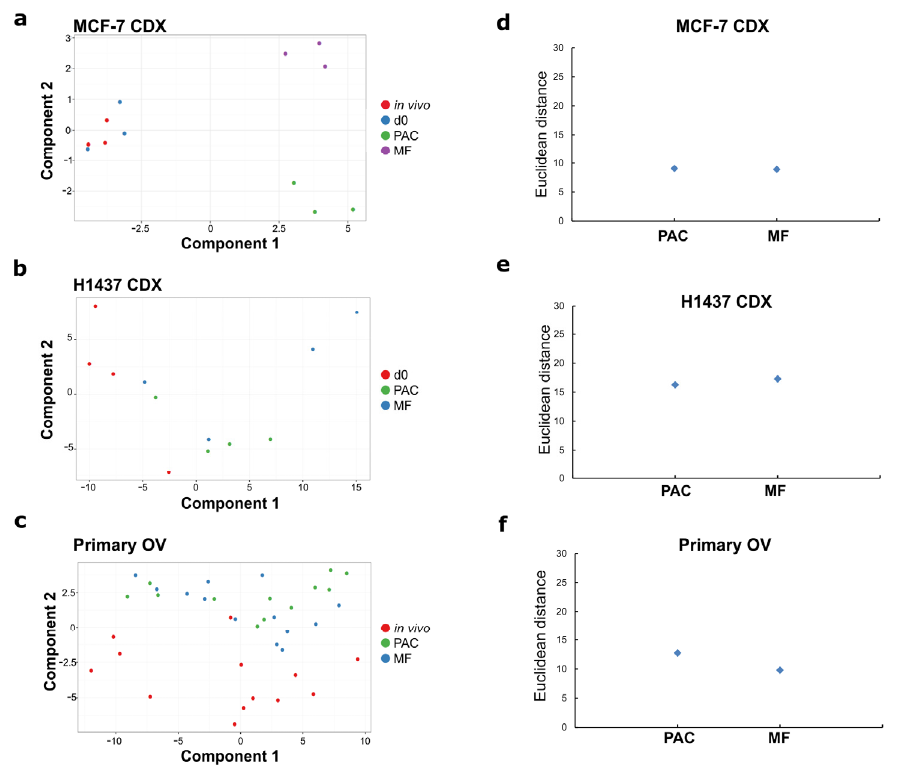
Figure 6. Evaluation of the changes in stress biomarkers under different conditions of tumor slice culture by principal component analysis (PCA). ( a – c ) PCA plots of the expression of 134 stress genes quantified under different conditions of tumor slice culture. ( d – f ) Scatterplots of the Euclidean distance of stress gene biomarker expression profiles of tumor slices compared to the expression profiles of the corresponding in vivo or d0 tumors. The tissue fixed immediately after surgical resection was defined as an in vivo tumor. The tissue after the slicing process and before tumor slice cultivation was defined as a d0 tumor. The results are from three mice of MCF-7 CDX for figures a and d, from four mice of H1437 CDX for figure b and e, and from 13 patients with ovarian tumors for figures ( c ) and ( f ).